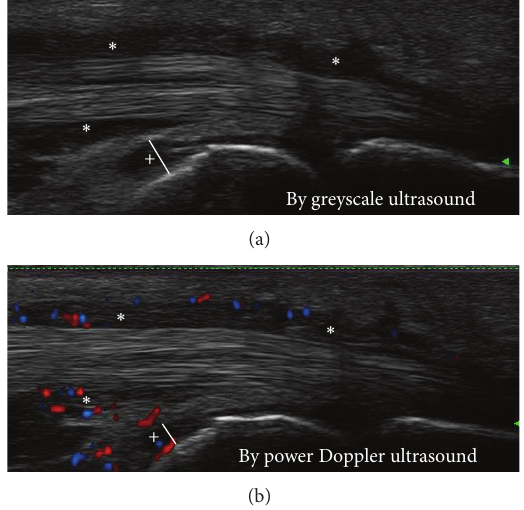
Figure 2: Tenosynovitis ( ∗ ) of the 2nd flexor tendon and synovitis (+) of the 2nd MCP joint—longitudinal